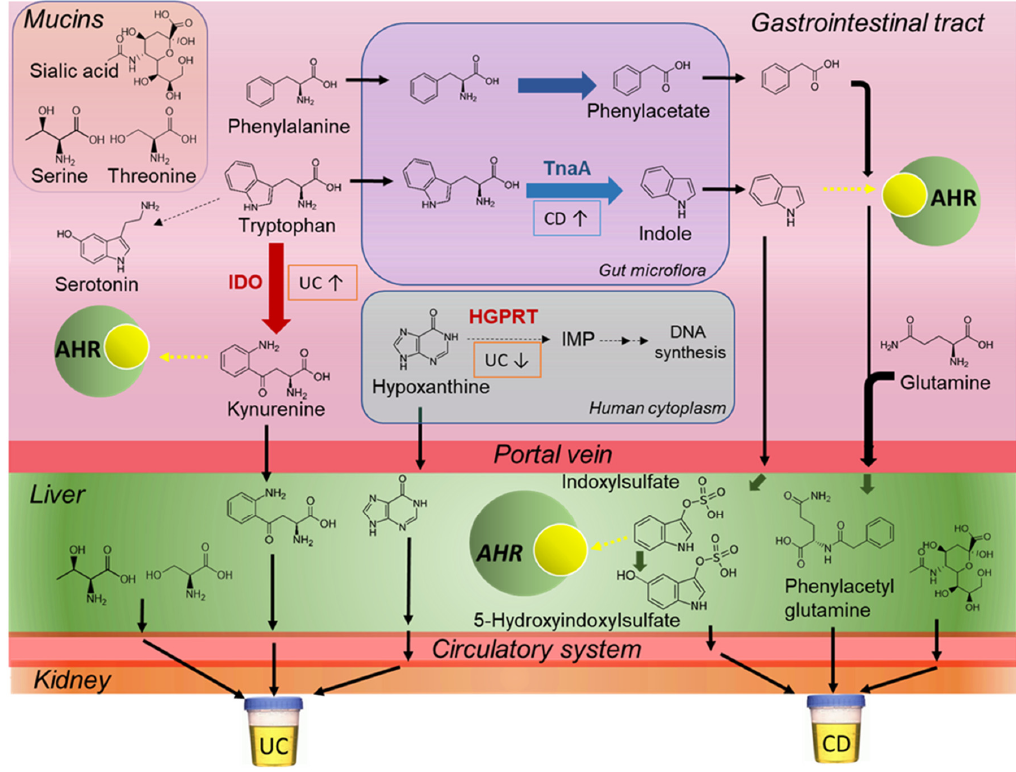
Figure 4. Proposed mechanisms that distinguish CD from UC pathophysiology based on differences in the urine metabolic phenotype of pediatric IBD subtypes prior to induction therapy. Key metabolic pathways include tryptophan/phenylalanine catabolism, mucin barrier function, and purine degradation pathways in the gut, liver and circulatory systems. Thick arrows represent enzymatic conversions and dotted arrow represent binding to AHR. AHR: aryl hydrocarbon receptor; IDO: indoleamine 2,3-dioxygenase; TnaA: tryptophanase, PAA: phenylacetic acid gene cluster; HGPRT: hypoxanthine-guanine phosphoribosyltransferase.